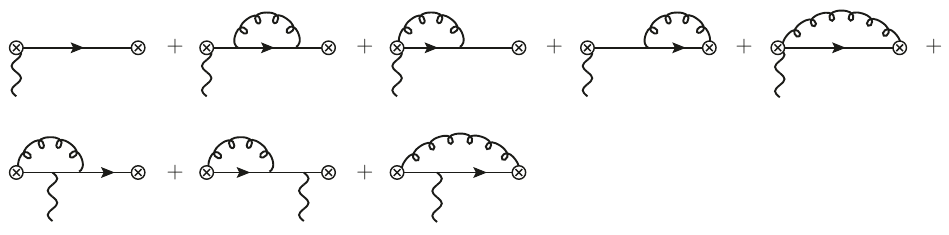
Figure 8 . Feynman diagrams contributing to the jet function J ( p 2 ) up to O ( (cid:11) s ).